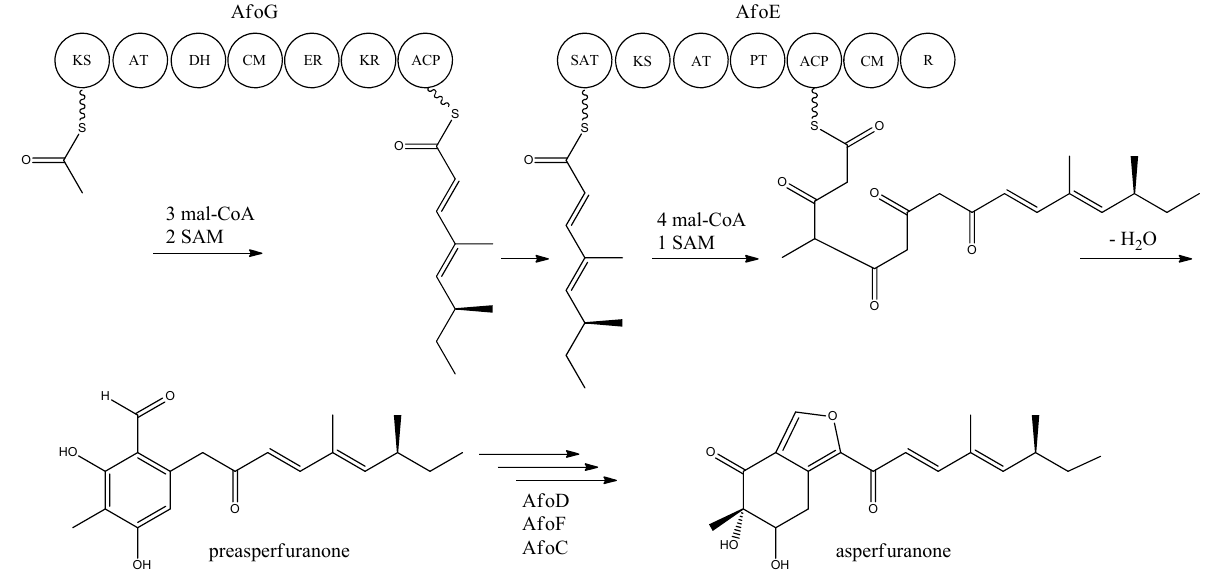
Figure 8. Proposed biosynthesis of asperfuranone. The highly reducing (HR)-PKS, AfoG, contains KS, AT, DH, CM, ER, KR, and ACP domains whereas the NR-PKS, AfoE, contains SAT, KS, AT,PT, ACP, CM , and R domains. The only intermediate isolated in the biosynthesis is preasperfuranone [89]. Multiple arrows indicate that the number of enzymatic steps and reaction order is